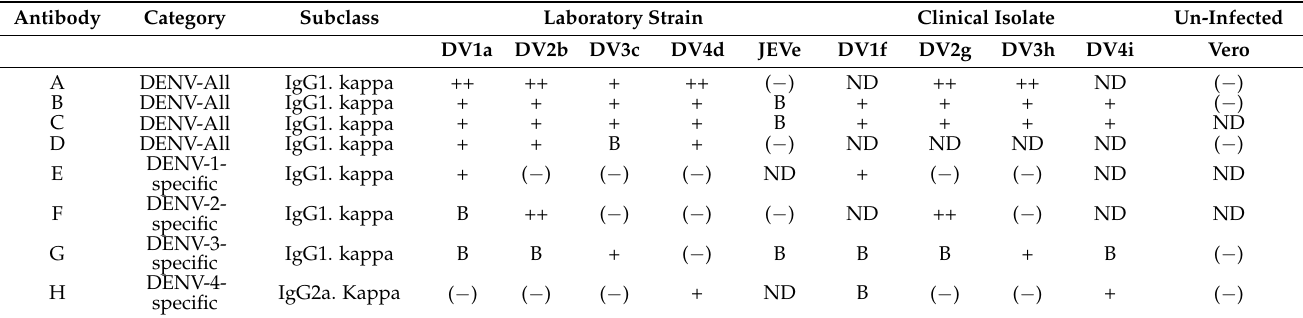
Table 2. Reaction of antibodies in indirect immunofluorescence assay of virus-infected